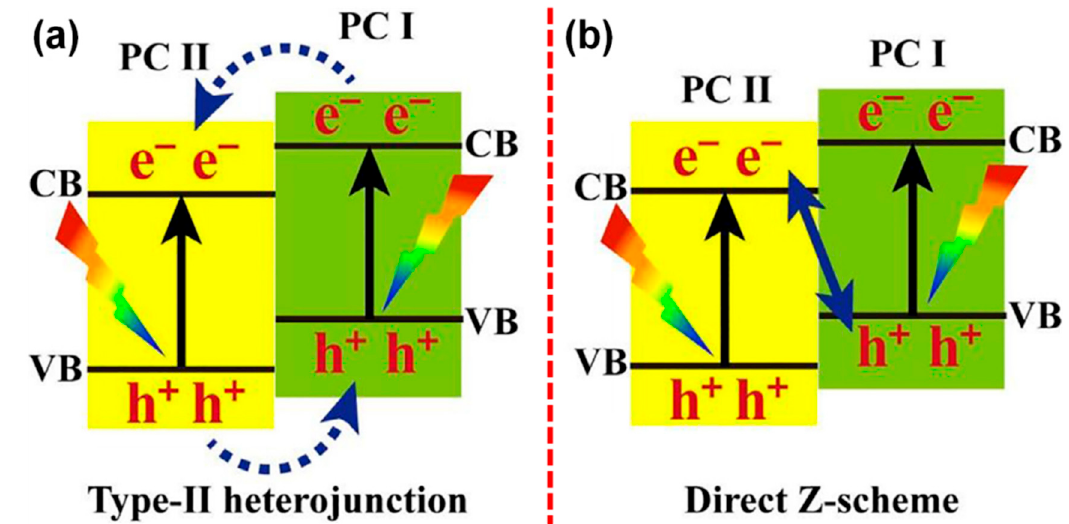
Figure 7. Schematic illustration of the ( a ) typical heterojunction and ( b ) Z-scheme photocatalysts (reproduced with permission from ref. [117]).